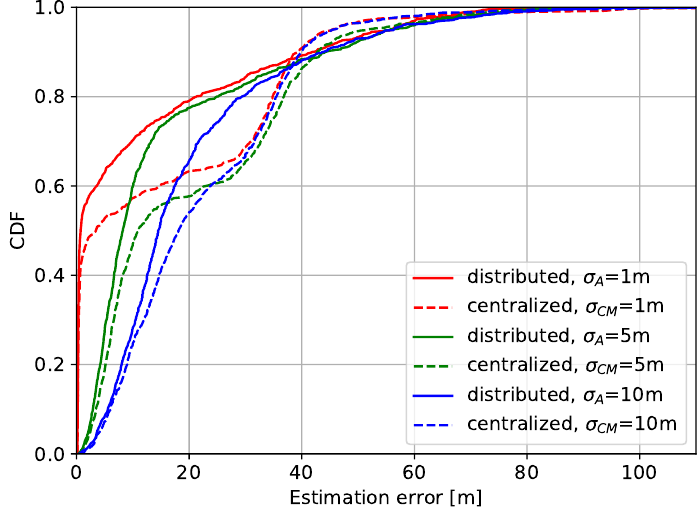
Figure 7. Cumulative distribution function of the localization error of the proposed